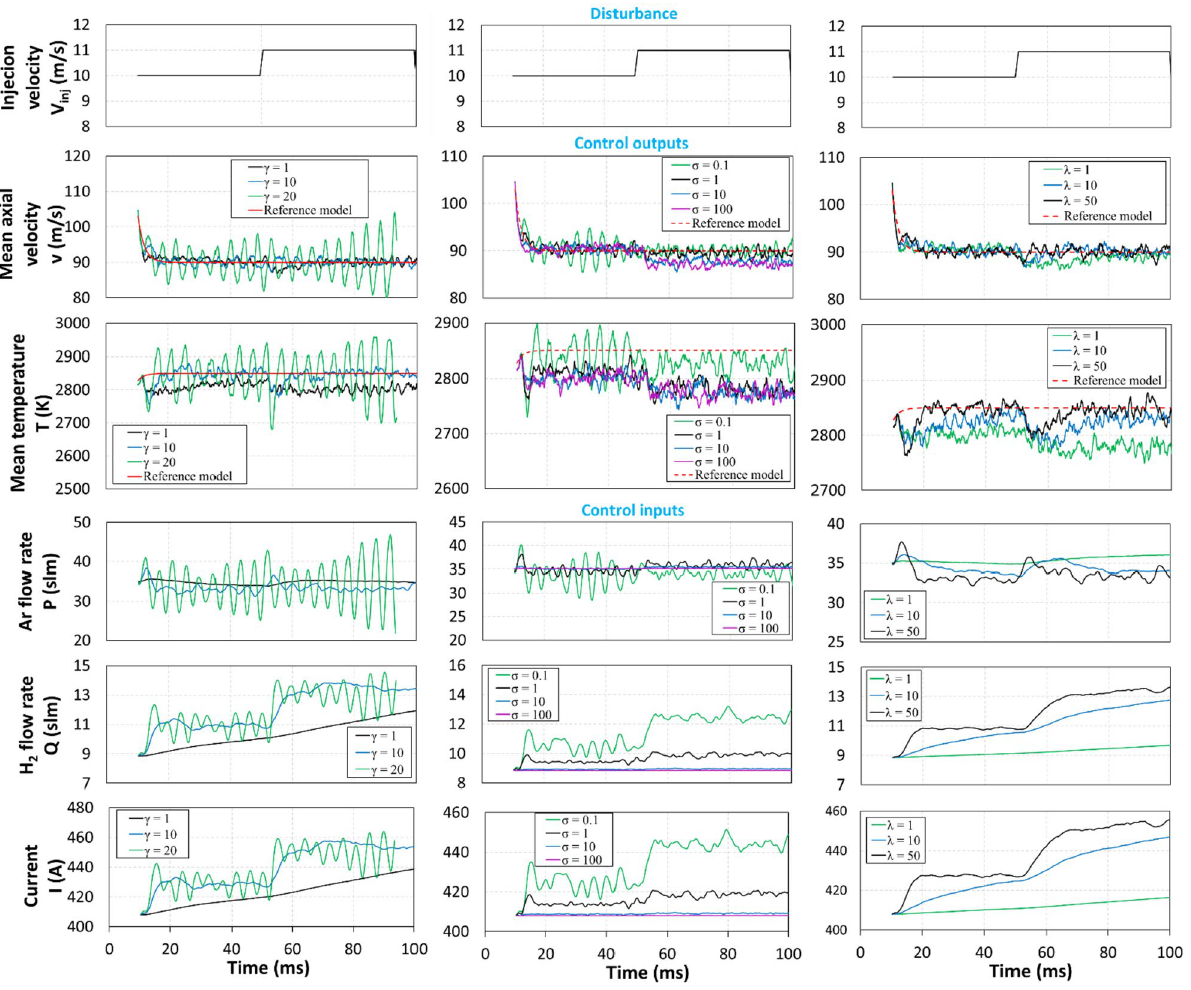
umn are with the damping constant 𝜎 in the R-MRAC scheme, and results in the third column are with the filter constant 𝜆 = 1, 10 and 50 in the MR-MRAC ( 𝛾 = 20 and 𝜎 = 100 )